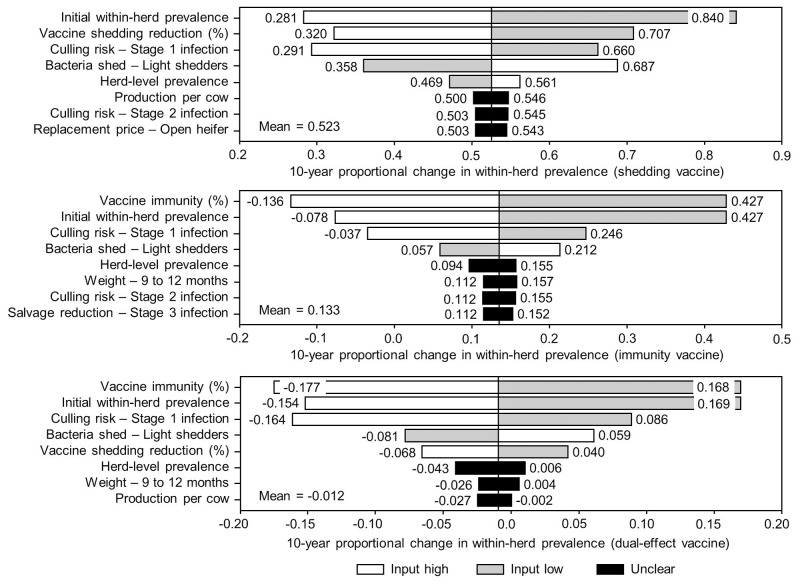
Sensitivity of 10-year proportional changes in within-herd Mycobacterium avium subsp. paratuberculosis (MAP) infection prevalence due to various JD (paratuberculosis) vaccine types to a range of input variables. Assumes initial mean values of 10% for within-herd MAP infection prevalence, 50% for herd-level prevalence, and 50% for vaccine efficacies. The color of the sensitivity bars indicates the direction of the relationship between the variable and 10-year proportional change in within-herd prevalence (grey indicates the effect of variable values below their mean value, white indicates the effect of values above their mean, and black indicates that the effect is unclear).